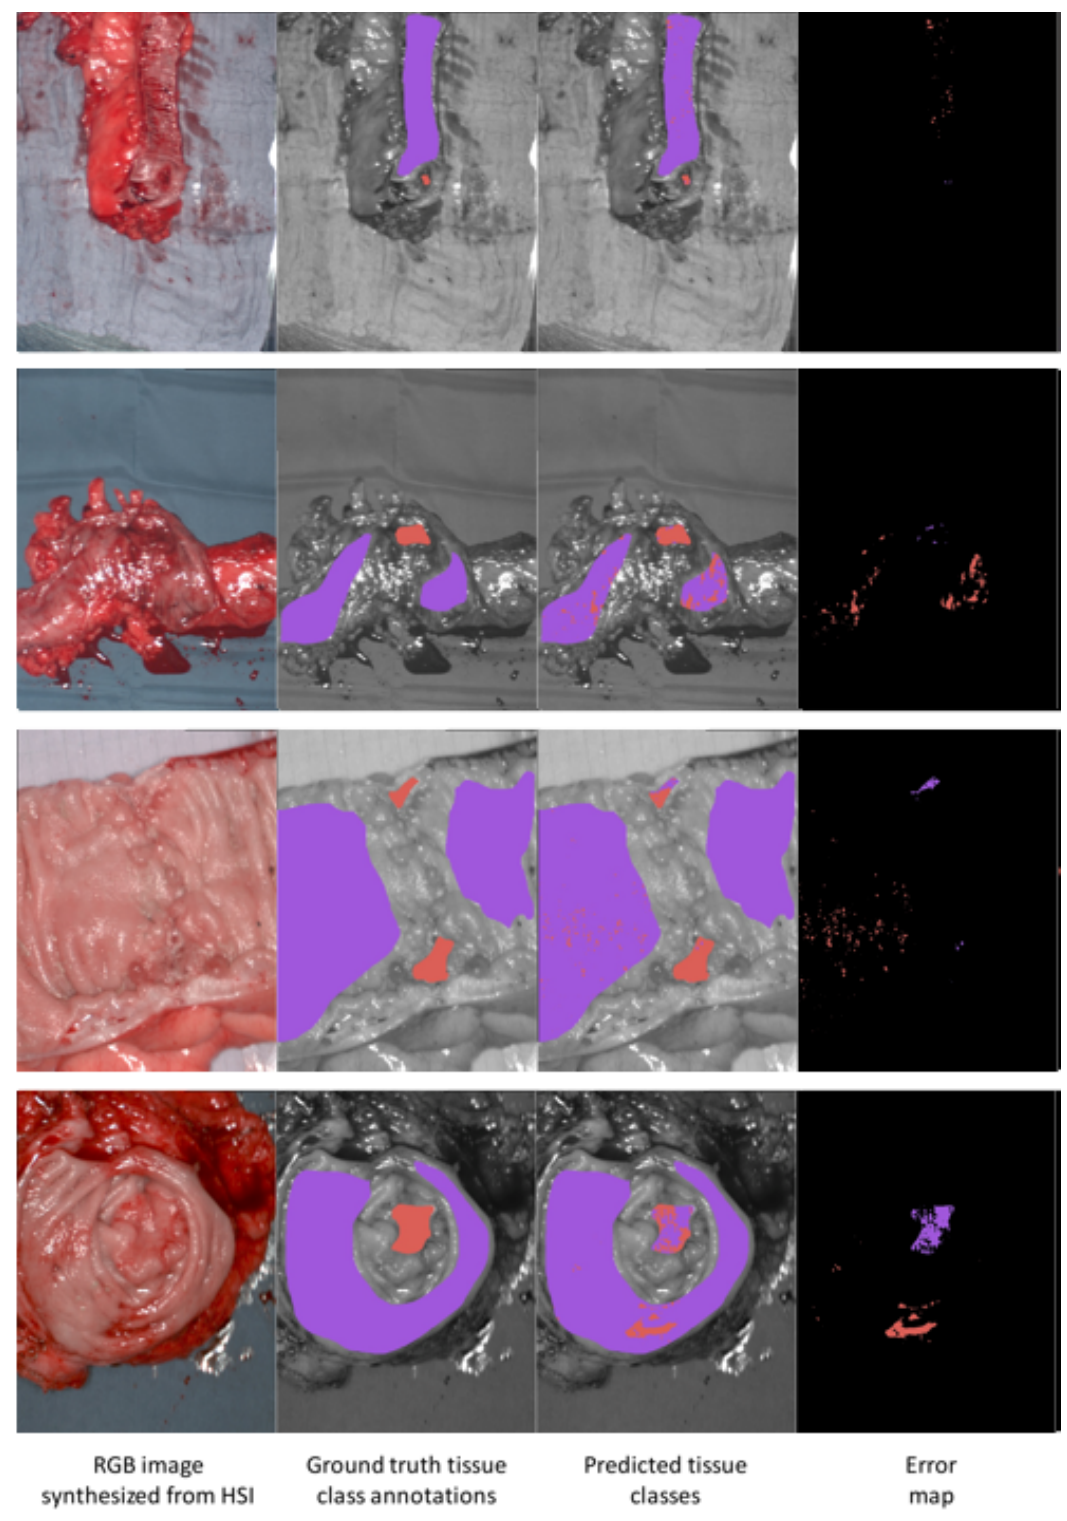
Figure 3. Visualization of results of the 3DCNN model on the colon dataset. Each row of images represents a patient (from top to bottom, patients 4, 3, 9 and 5). Each row of images shows four images. From the left, these are: (1) The RGB image synthesized from the hypercube. (2) The ground truth tissue class annotations provided by the surgeon. (3) The predicted tissue classes predicted by the 3DCNN. (4) The error map. Colored pixels in the error map indicates pixels where the 3DCNN prediction differed from ground truth. The displayed color is the color of the incorrect prediction from the 3DCNN. Pixels in red correspond to the tumor class, and pixels in purple correspond to the healthy tissue